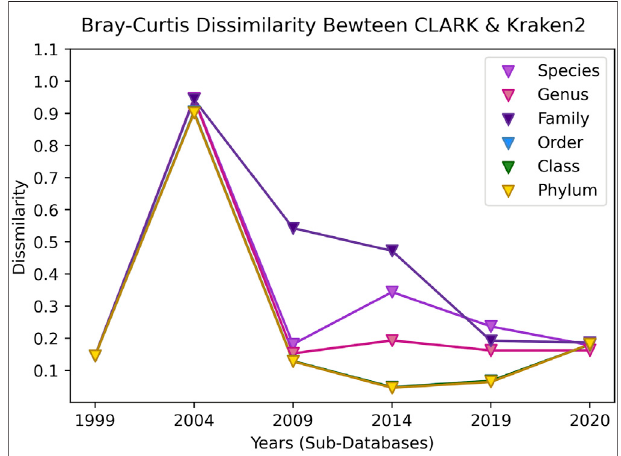
FIGURE 20 | The Bray-Curtis dissimilarity between the classi fi ed results of CLARK and Kraken 2 for each taxonomic level over time (increasing databasesize).Sinceonly4organismsfrom4differentphylawereclassi fi edin 1999, the similarity of the results is close. In 2004, a distinct issue is that CLARK classi fi ed signi fi cantly more reads than Kraken 2, which skewed the dissimilarity to be signi fi cant for all taxonomic levels. In 2009, the methods are more concordant, and for the rest of the years, the species-level classi fi cation is different while the phylum classi fi cation is more similar. The methods are pretty similar on all taxonomic levels once again in